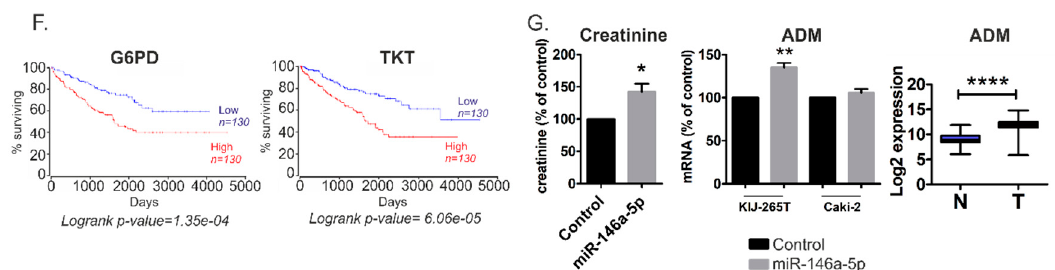
Figure 4. The effects of miR-146a-5p transfection in RCC cells. (A) Principal component analysis (PCA) of transcriptome data obtained from KIJ265T cell line transfected with miR-146a-5p mimic or non-targeting control oligonucleotide (Cont. ( B ) Hierarchical clustering based on di ff erentially expressed genes generated using TAC 4.0. (C) Top pathways a ff ected by miR-146a-5p transfection in RCC cells. The plot shows results of IPA Core Analysis performed on the genes a ff ected by transfection of miR-146a-5p mimic (shown in Table S4). The overrepresented pathways are listed according to the –log ( p value) (blue bars) (left y-axis). The threshold line (green) represents p value = 0.05. The ratio of the number of genes found in each pathway and the total number of genes in the pathway is shown in orange (right y-axis). PPP pathway is shown with arrows. (D) The expressions of genes involved in the pentose phosphate pathway ( G6PD , TKT ) are upregulated in RCC cells transfected with miR-146a-5p mimic. The e ff ect of miR-146a-5p was analyzed in three independent biological experiments performed in triplicate. Statistical analysis was performed using t-test. * p < 0.05. ** p < 0.01. ( E ) The expression of G6PD and TKT in RCC tumors classified according to TNM system [1]. T1 ( n = 30): tumors classified as Stages I and II (tumors limited to the kidney, with no signs of metastasis); T2 ( n = 30): tumors classified as Stages III and IV (tumors which invade veins and neighboring structures as well as tumors with metastasis in lymph nodes or distant organs). Statistical analysis was performed using Mann–Whitney test. ** p < 0.01. ( F ) High expressions of G6PD and TKT correlate with poor survival of RCC patients. Kaplan–Meier plots of RCC patients were generated using OncoLnc tool and KIRC cohort of TCGA data. Patients were classified into Low and High expression groups basing on median gene expression data. ( G ) miR-146a-5p transfection increases creatinine levels in RCC cells. Left panel: The plot shows results of GC-MS analysis of RCC cells transfected with miR-146a-5p mimic or non-targeting control oligonucleotide. Middle panel: The expression of adrenomedullin ( ADM ) is increased in KIJ265T RCC cells transfected with miR-146a-5p mimic. Right panel: The expression of ADM is increased in RCC tumors (T, n = 250) when compared with control kidney samples (C, n = 72). The analysis was performed using publicly available transcriptomic data of TCGA consortium (KIRC cohort). Statistical analysis was performed using t-test. * p < 0.05. ** p < 0.01. **** p <